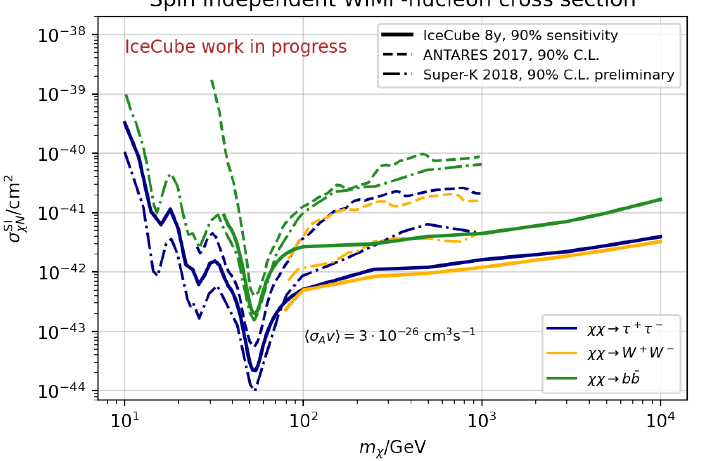
Figure 2. Limits on the spin-independent WIMP-nucleon scattering cross-section of ANTARES [31], SuperK [32] and sensitivities of IceCube [33] at 90% C.L. Figure reproduced from [33], credit: IceCube